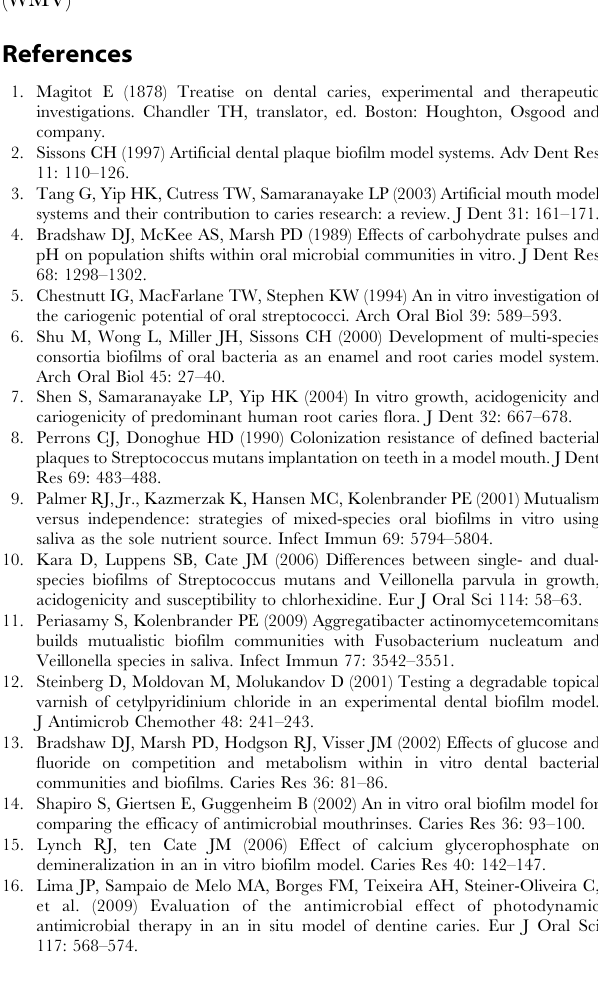
Table S1 Sequences of primers used for PCR amplifi- cation and sequencing. Table S2 Sequences of newly designed oligonucleotide